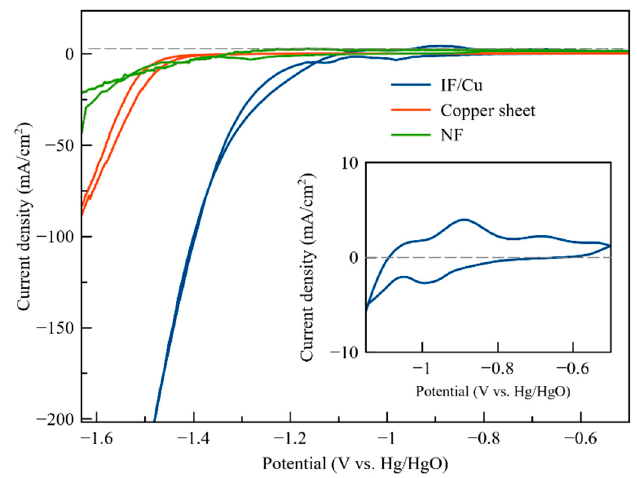
Figure 3. Cyclic voltammetry (CV) of copper sheet, IF / Cu and NF substrates at a scan rate of 7 mV / s within a potential range of − 1.7 to 0.5 V vs. Hg /